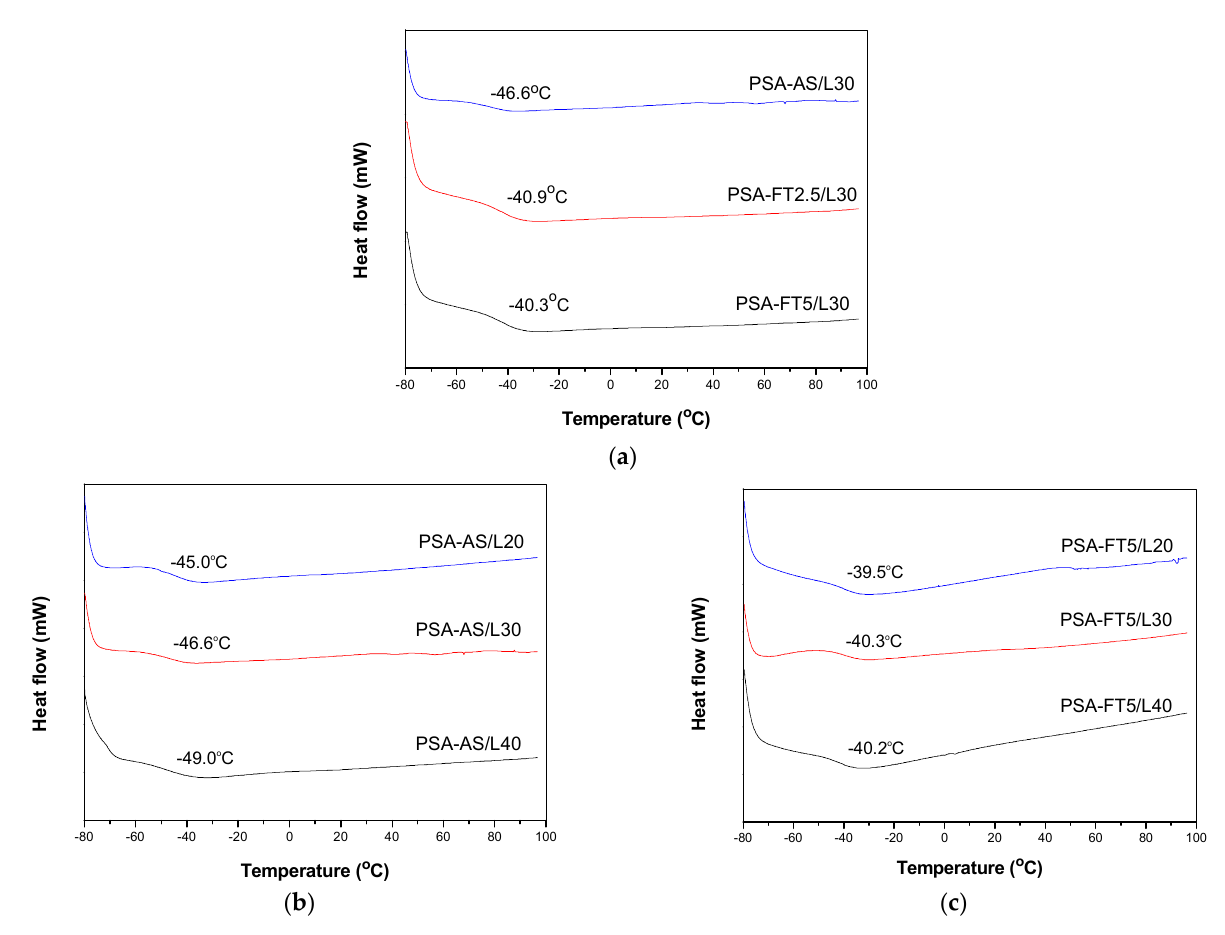
Figure 11. DSC thermograms for PSA (6 wt. parts of L9033; UV dose of 8 J/cm 2 ) containing the syrups with 30 wt. parts of LMA and different fluorotelogen contents ( a ), without fluorotelogen and with different LMA contents ( b ), with 5 wt. parts of the fluorotelogen and different LMA contents ( c ). Interestingly, the fluorotelomer-based PSA samples (FT2.5/L30 or FT5/L30) exhibited almost identical glass transition temperature values ( − 40 ◦ C); they were only slightly higher (by 7 ◦ C) than the T g of the acrylate syrups-based systems (Figure 11a). These components were characterized by different Mn values (Table 2); in the fluorotelogen-free sample, the molecular weight of the linear acrylate copolymers was much higher (22,000 g/mol) in relation to PSA with the FT-type syrups (1400 and 1300 g/mol, respectively). On the other hand, the SC values were similar (ca. 70%; Table 2). It can be concluded that the cross- linking density was higher in the fluorotelomer-based PSA materials (the photocrosslinking process of the unreacted monomers and the crosslinking monomer is easier in the presence chains and increases the T g value. The content of the methacrylate monomer (with long aliphatic chains) in PSA also influences this parameter value. The known T g of